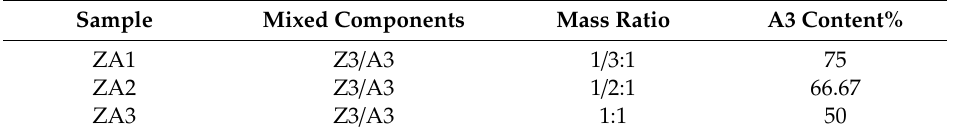
Table 1. Proportion and state of compound-hardened sol solution blended with di ff erent components.